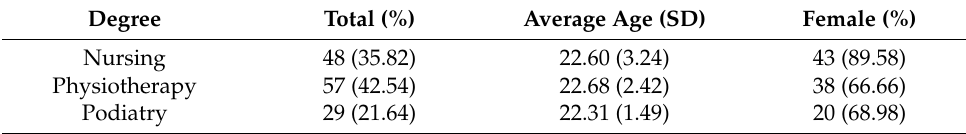
Table 2. Distribution of students according to degree, average age and female. Degree Total (%)